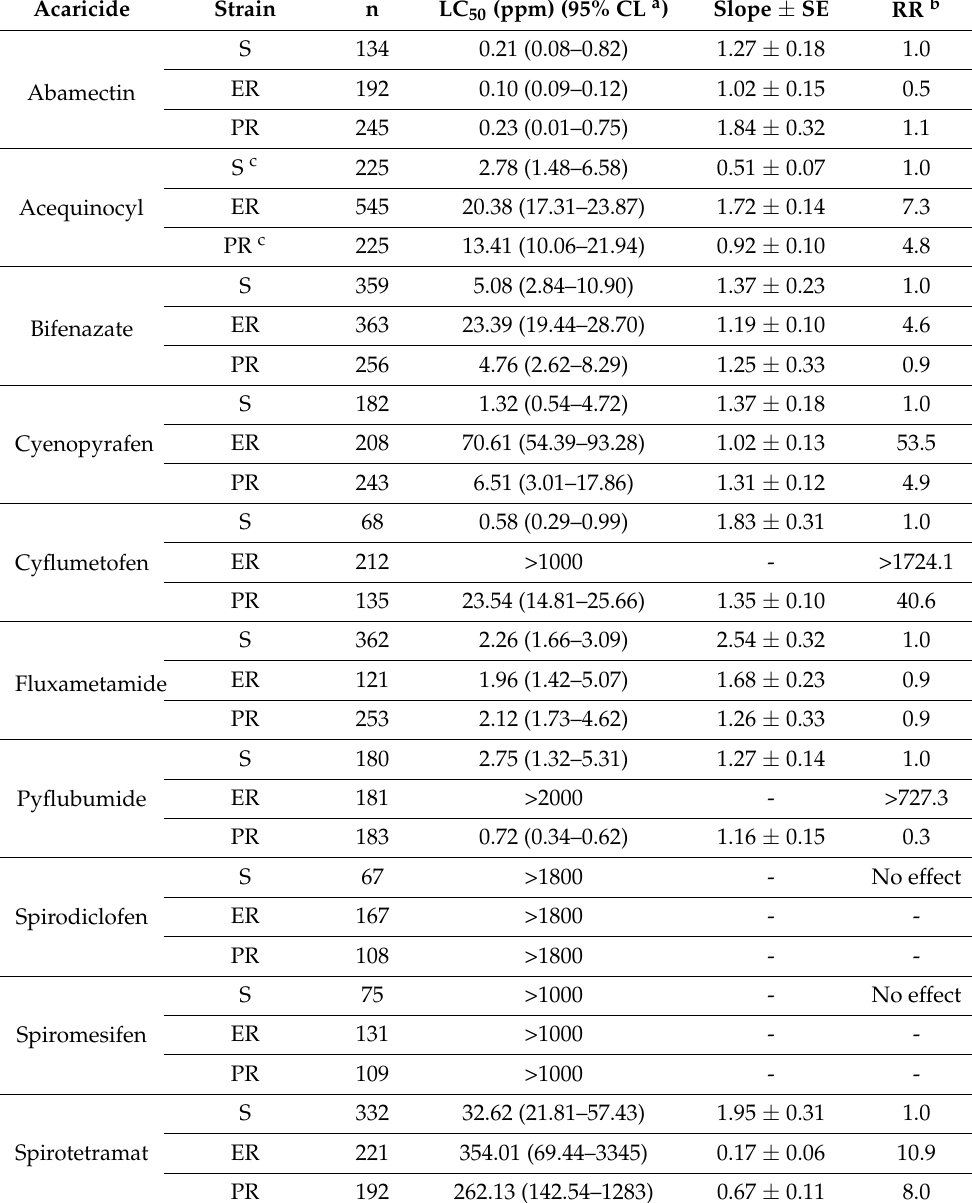
Table 5. Susceptibility to acaricides in adults of the S, ER, and PR strains of T. urticae